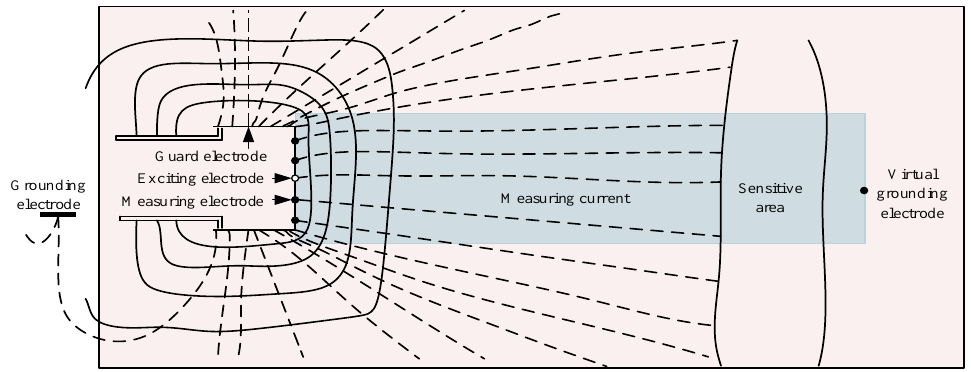
Figure 1. The working principle of coal mine inclined shaft advanced detection method based on shield cutterhead moving array electrodes.